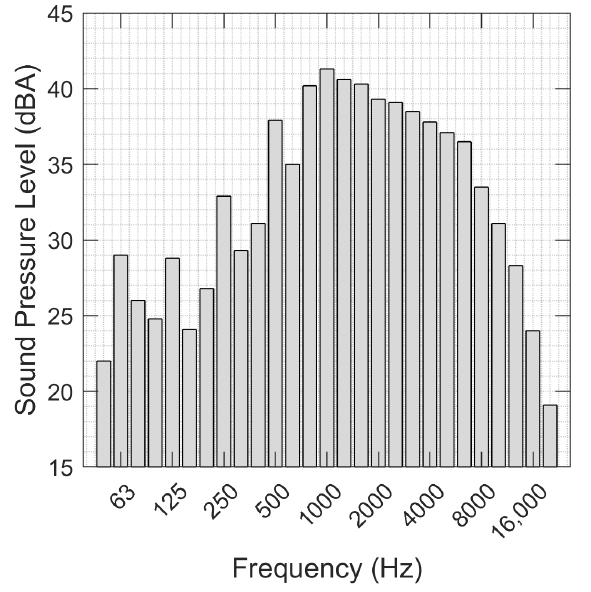
Figure 6. Hover tests—third octave band results 30 m 90 ◦